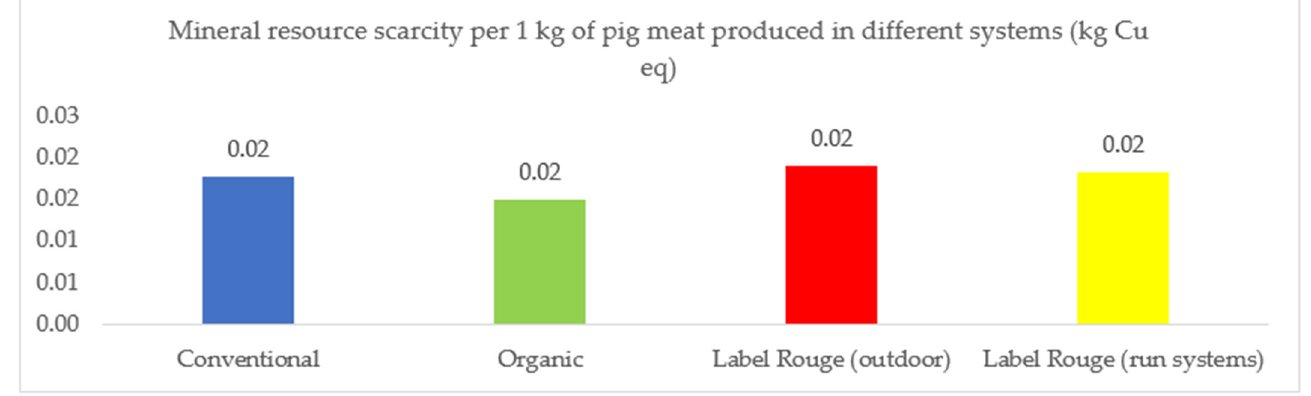
Figure 8. Mineral resource scarcity per 1 kg Pig meat across organic, Label Rouge and Conventional systems: Data obtained from AGRIBALYSE ® database and computed using OpenLCA 1.10.2 [35,36].